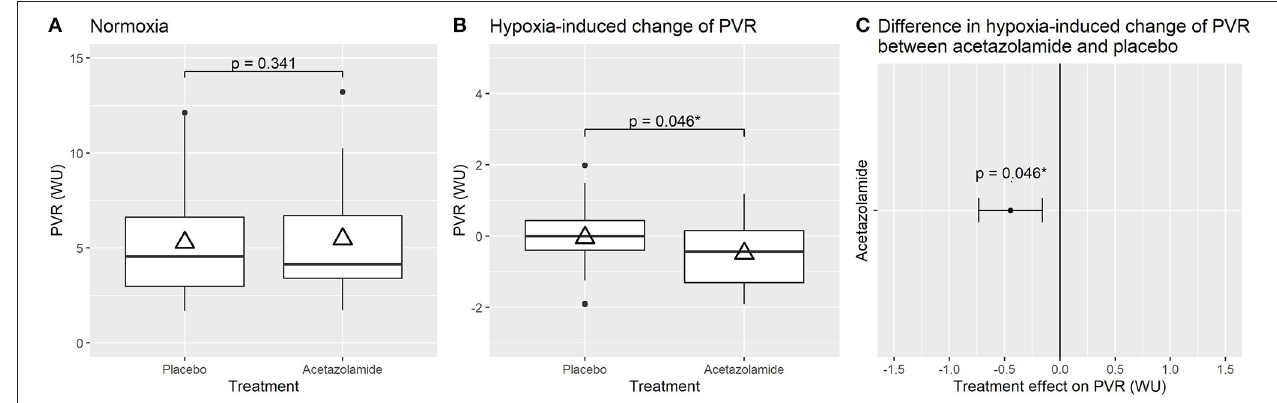
FIGURE 2 | Effect of treatment with acetazolamide vs. placebo on pulmonary vascular resistance (PVR) under ambient air (A) , on the hypoxia-induced change in PVR (B) and mean difference (95% confidence interval) in hypoxia-induced change between acetazolamide and placebo treatment (C) . Acetazolamide did not have a significant effect on PVR under ambient air (A) , under hypoxia, PVR remained unchanged with placebo but was significantly reduced by acetazolamide (B,C) . Boxplots (A,B) with horizontal line = median; upper and lower box edge = interquartile ranges [IQR]; length of whiskers = 1.5 × IQR; dots = outliers; and triangles = means. Statistically significant values ( p < 0.05 or 95% CI not including 0) are denoted with